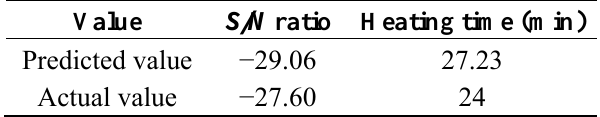
Table 6. Comparison of predicted value and actual value of